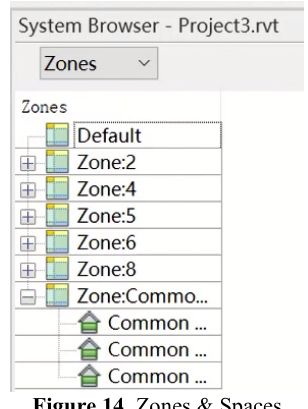
Figure 14. Zones &